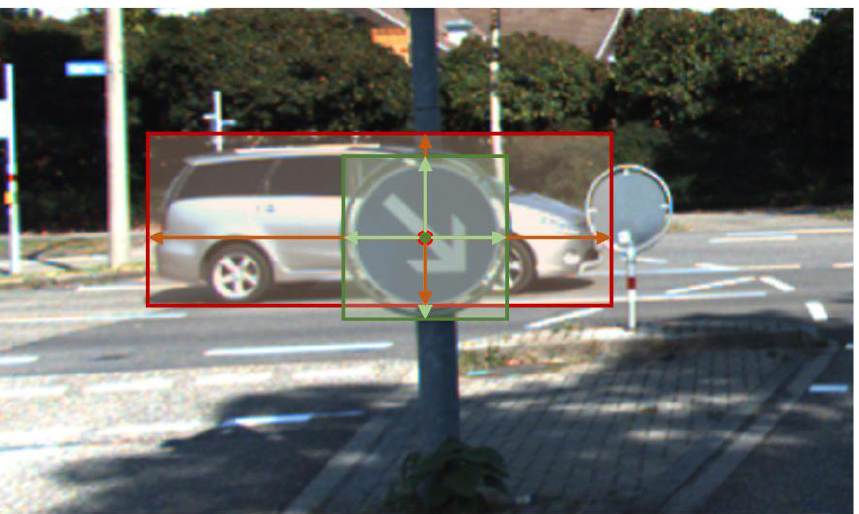
Figure 8. Overlap between different scales of objects. A feature pyramid is used to solve the problem of a point representing multiple semantics, and boundary boxes of different sizes are predicted on various feature layers.